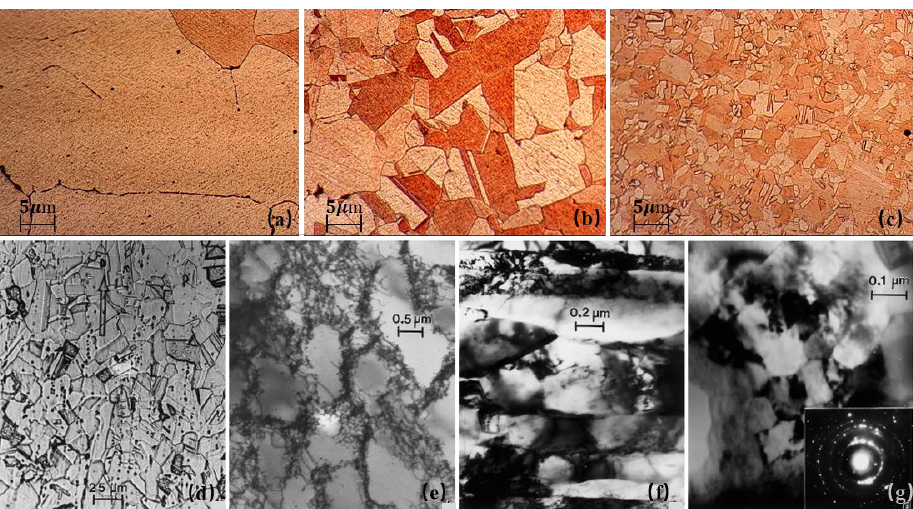
Figure 2. Surface morphology of T2 copper in different rolling passes: ( a ) billet; ( b ) 1 pass; ( c ) 10 pass; ( d ) light microscope view along a longitudinal half-section of a commercial copper rod; ( e ) TEM bright-field image of dislocation cells corresponding to the longitudinal view in a; ( f ) TEM bright-field image of longitudinal section; ( g ) TEM bright-field image for transverse section corresponding to c.